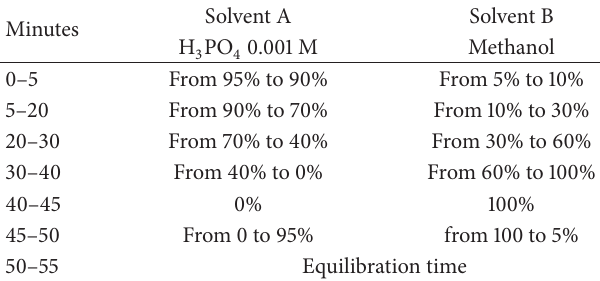
Table 2: HPLC mobile phase gradient conditions.